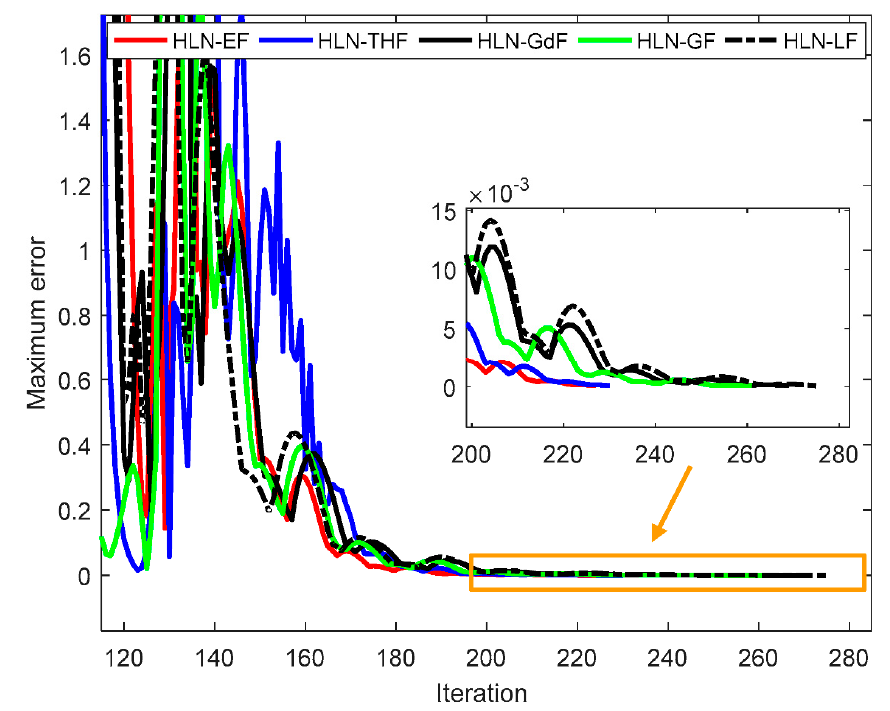
Figure 13. Zoom-in of Figure 12 from iteration 115 to the last iteration.